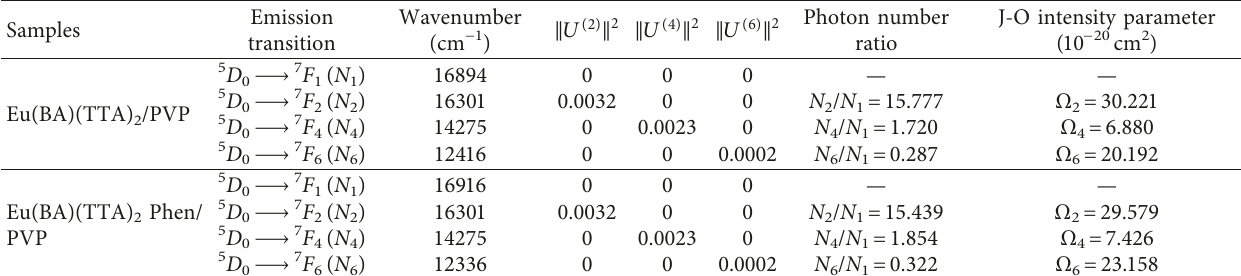
3+ in Eu(BA)(TTA) 6 ) of Eu 2 /PVP Ω Ω Ω